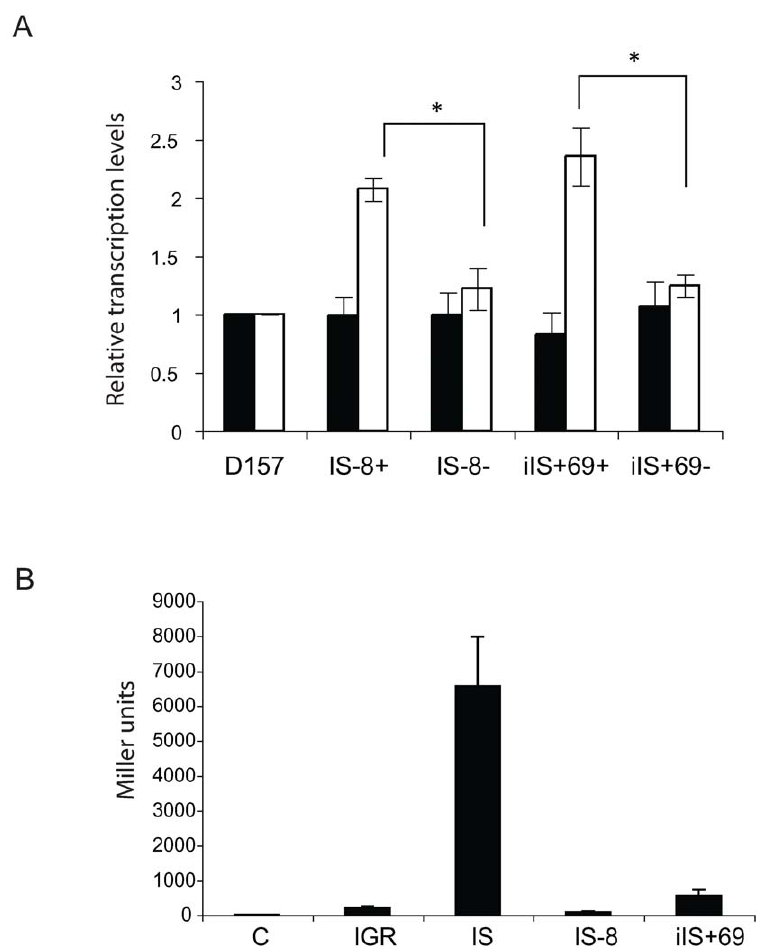
Figure 2. Expression of capsule biosynthesis genes. A: Relative levels of siaA (black bars) and ctrA (white bars) mRNA transcripts measured by qrtRT-PCR. P , 0.005 (*) for differences in ctrA mRNA levels in IS-8 + and iIS + 69 + versus the controls, using Student’s t test. B: b -galactosidase activity was determined for siaA translational fusions. C denotes a control without an IGR. Results are average of three independent experiments, and error bars indicate the standard deviation